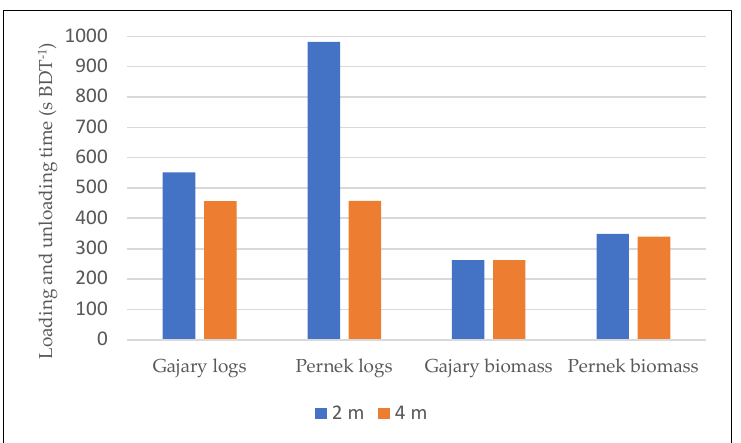
Figure 3. Loading and unloading efficiency for the two sites, log length specifications and feedstock types.